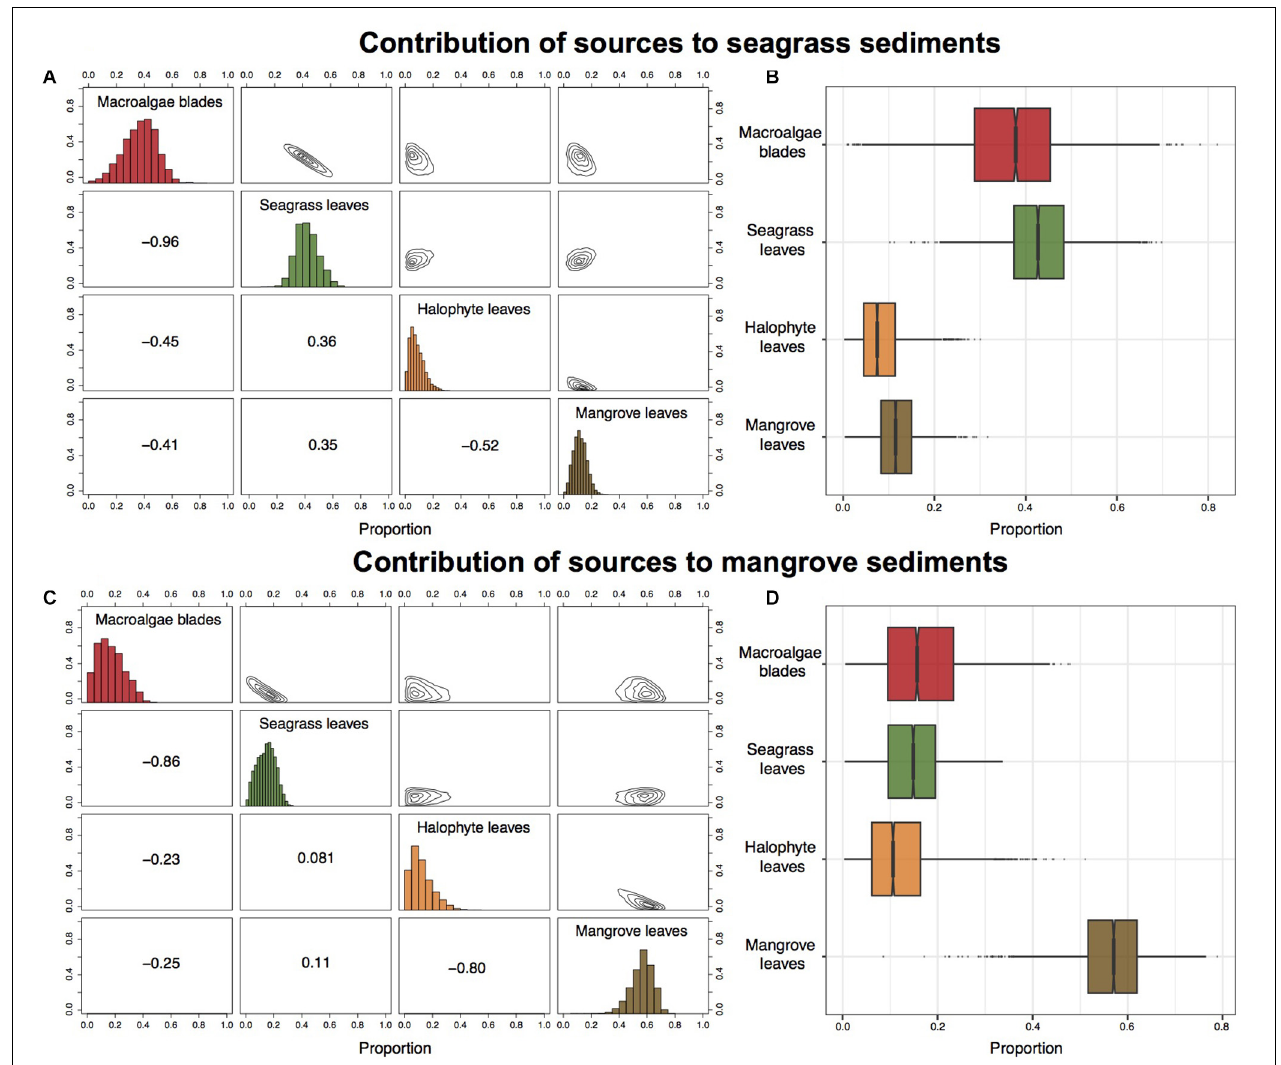
FIGURE 8 | Contribution of primary producers to the accumulated organic matter in seagrass (A,B) and mangrove (C,D) sediments in the Red Sea calculated using Bayesian mixing models. Matrix plots for seagrass (A) and mangrove (C) sediments, showing probability distributions of each source (in diagonal panels), the joint probability between pairs of sources (in top panels), and the correlations between pairs of sources (in bottom panels). Box plots of the proportional contribution by each source to seagrass (B) and mangrove (D) sediments. Boxes extend from the 25 th to 75 th percentiles and lines inside boxes represent mean